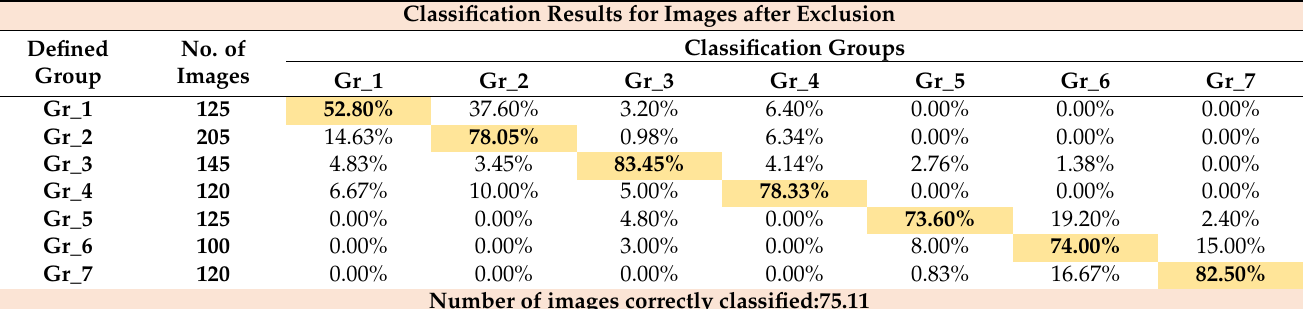
Table 4. Classification results for the modified groups (subgroups excluded). Classification Results for Images after